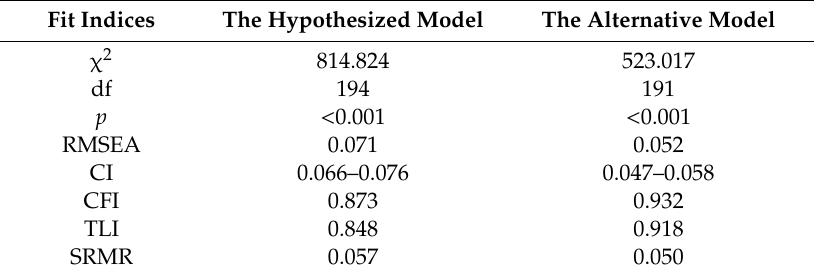
Table 4. The test of model fit from the six-factor solution proposed by Main and Grove (2009) and the alternative model taking three measurement errors into